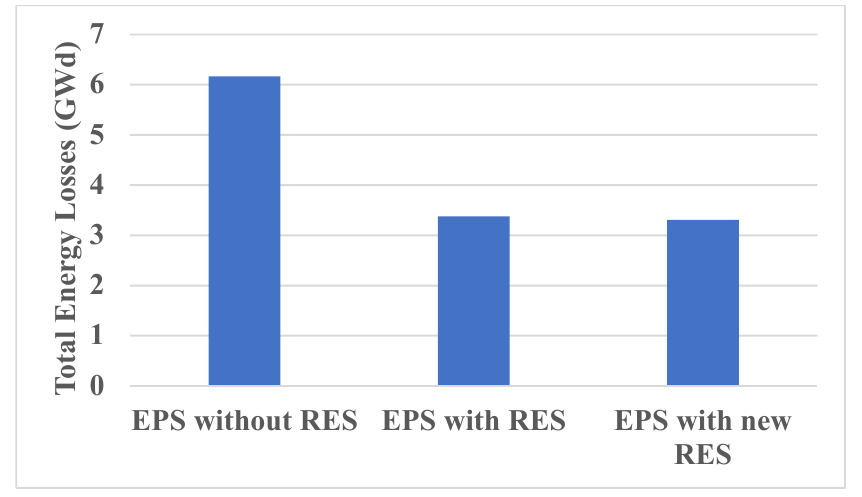
Figure 22. Total annual energy losses.